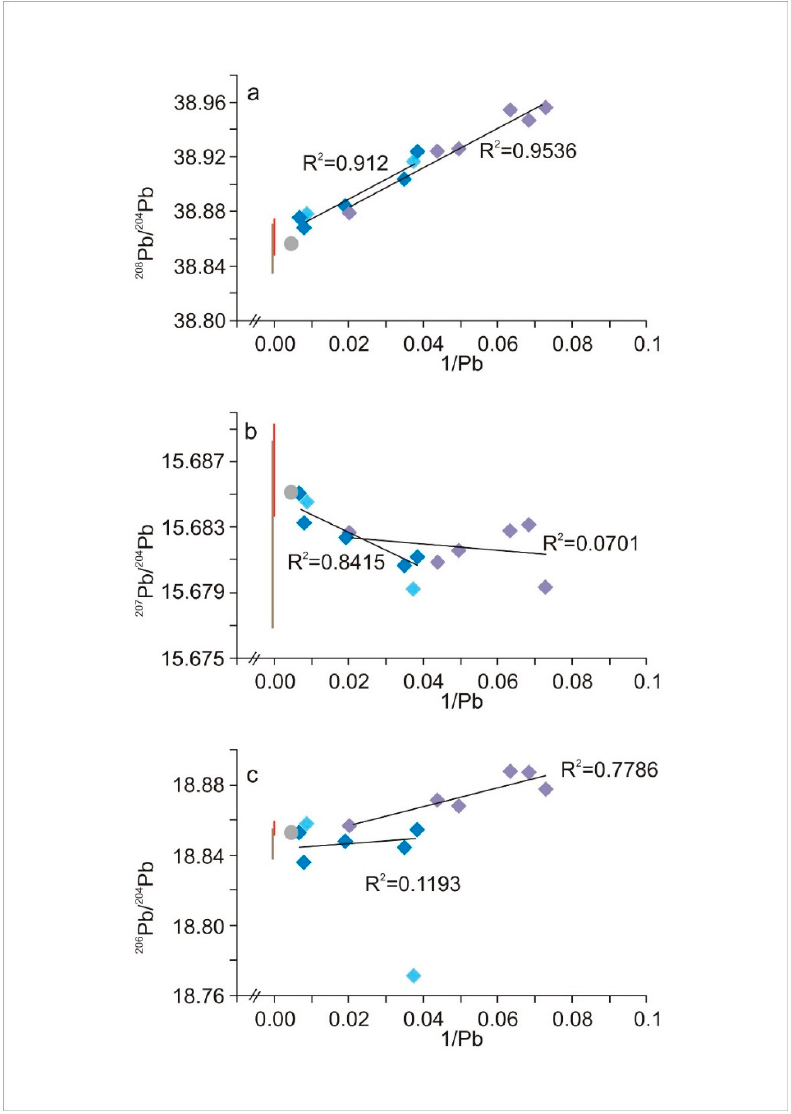
Figure 4. Lead isotopic composition vs. lead concentration. ( a ) 208 Pb/ 204 Pb vs 1/[Pb] (µg g -1 ), ( b ) 207 Pb/ 204 Pb vs 1/[Pb] (µg g -1 ), and ( c ) 206 Pb/ 204 Pb vs 1/[Pb] (µg g -1 ). Note: The concentrations are reported as 1/[Pb] (µg g -1 ), so higher concentrations are on the left-side of the x-axis. The red vertical trait symbolizes the lead isotopic composition of the lead sheathing, the light-brown vertical trait symbolizes the lead isotopic composition of the anchor (values reported from van Duivenvoorde [5]). The other symbols are similar to the symbols used in Figure 3.